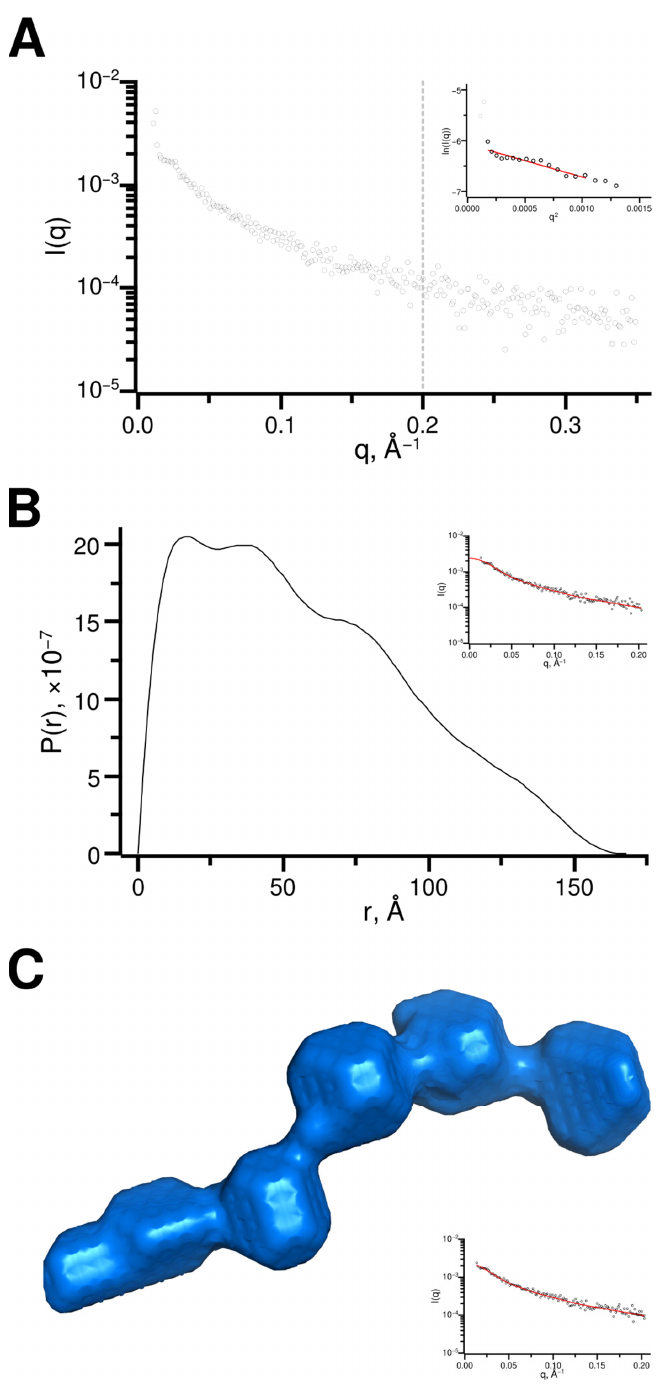
Figure 7. SEC-SAXS data analysis ( A ) Scattering curve representing the averaged scattering from frames 96 to 108, as highlighted in Supplementary Figure S5. Data beyond q of 0.2 Å − 1 (grey dotted line) was excluded from the rest of the analysis. The Guinier region is shown in the inset. ( B ) Pair distribution (P(r)) function determined using GNOM and manual adjustments to achieve a probability function that gradually approaching zero at maximum dimension. The fit to experimental data is shown in the inset. ( C ) Surface representation of an ab initio CAF-1 p150L model as calculated by DAMMIF and further refined by DAMMIN. The fit to the experimental data is shown in the inset. Scattering data has been deposited in the Small Angle Scattering Biological Data Bank (SASBDB) under the accession number